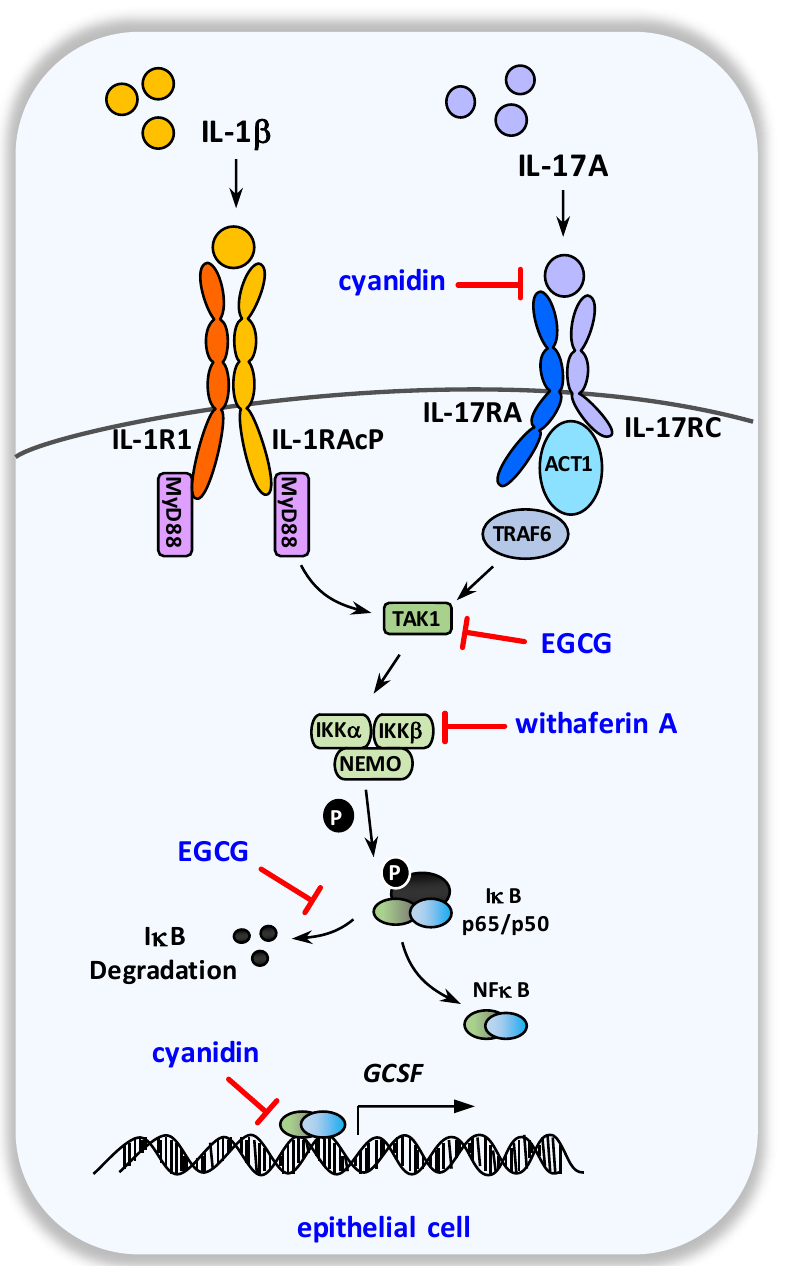
Figure 4. Schematic overview of the molecular targets of EGCG, withaferin A, and cyanidin within the G-CSF pathway . After binding to and signaling through their specific heterodimeric receptors, the G-CSF-inducers IL-1 β and IL-17A provoke NF- κ B activation and the subsequent upregulation of G-CSF expression in epithelial cells.